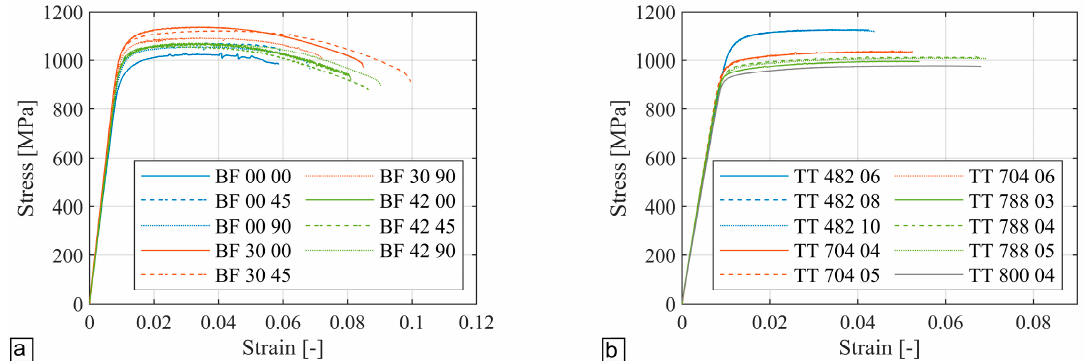
Figure 10. Stress–strain curves for ( a ) the barrel-finished samples and ( b ) the heat-treated samples.